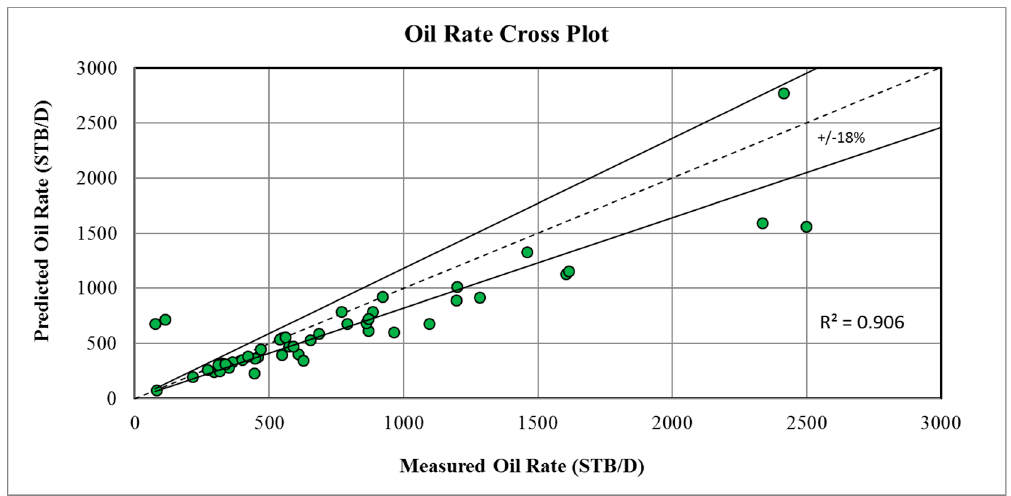
Figure 11. Predicted vs measured oil rate using the Darcy correlation.